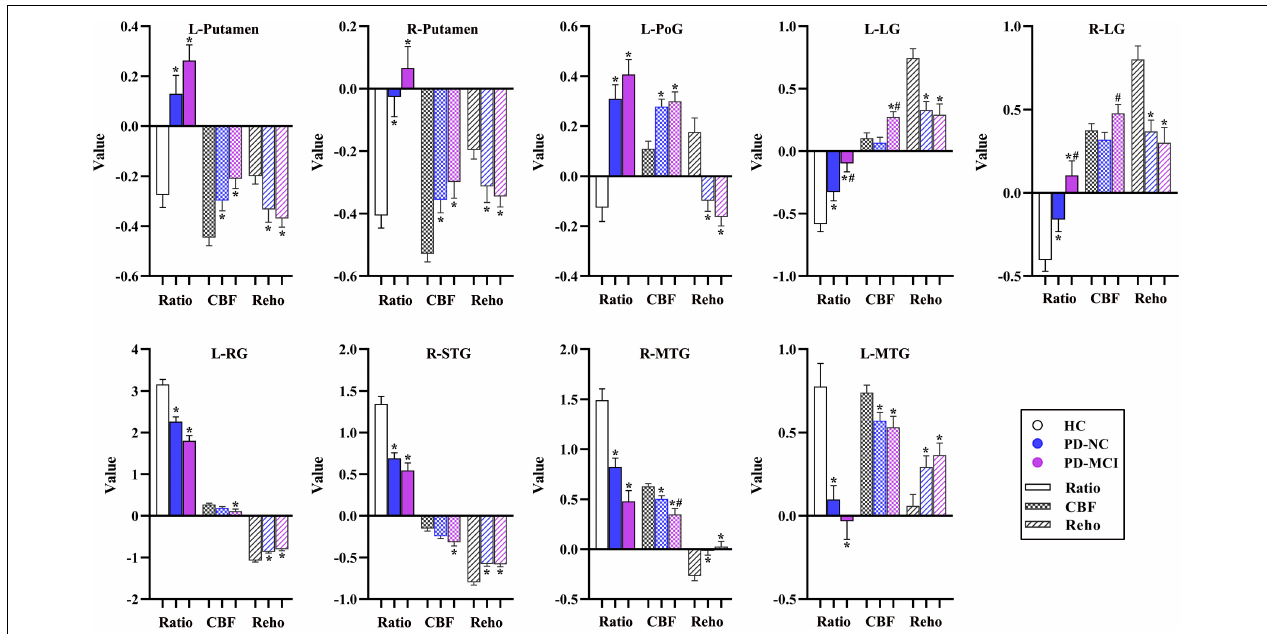
FIGURE 6 | The alterations of CBF-ReHo ratio, CBF, and ReHo in brain regions with significant group differences using the voxel-based analyses. *Indicates significant intergroup difference to the HC group; # indicates significant intergroup difference to the PD-NC group. CBF, cerebral blood flow; ReHo, regional homogeneity; PD, Parkinson’s disease; NC, normal cognition; MCI, mild cognitive impairment; L, left; R, right; PoG, postcentral gyrus; LG, lingual gyrus; RG, rectus gyrus; STG, superior temporal gyrus; MTG, middle temporal